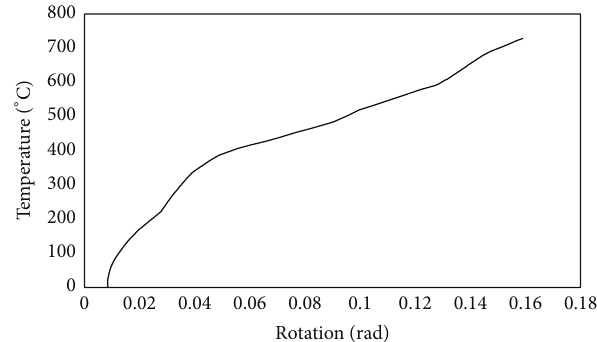
Figure 22: Parameters needed to calculate the stiffness of the connection.